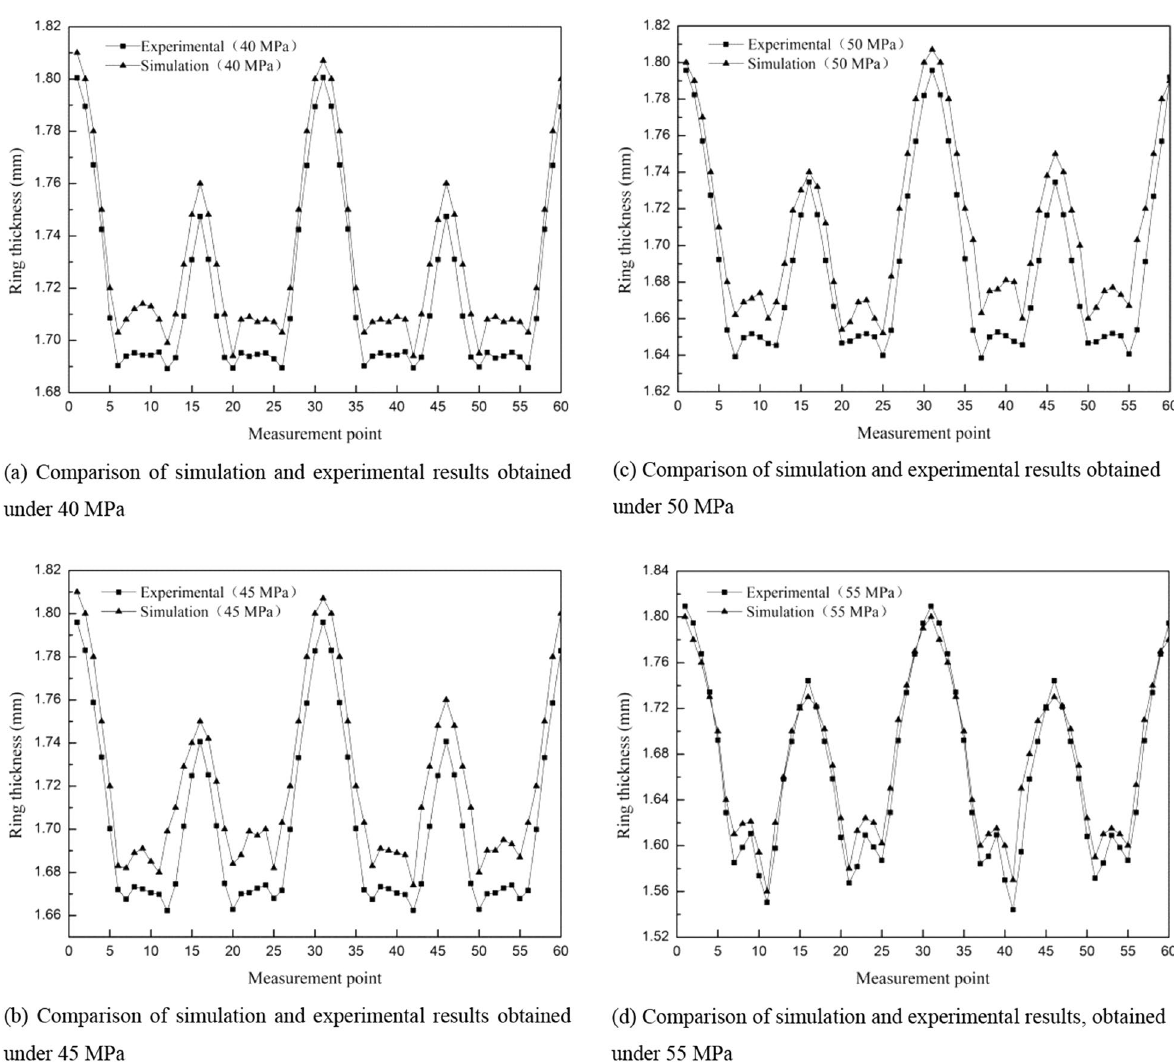
Figure 18 Comparison of simulation and experimental results obtained under different internal